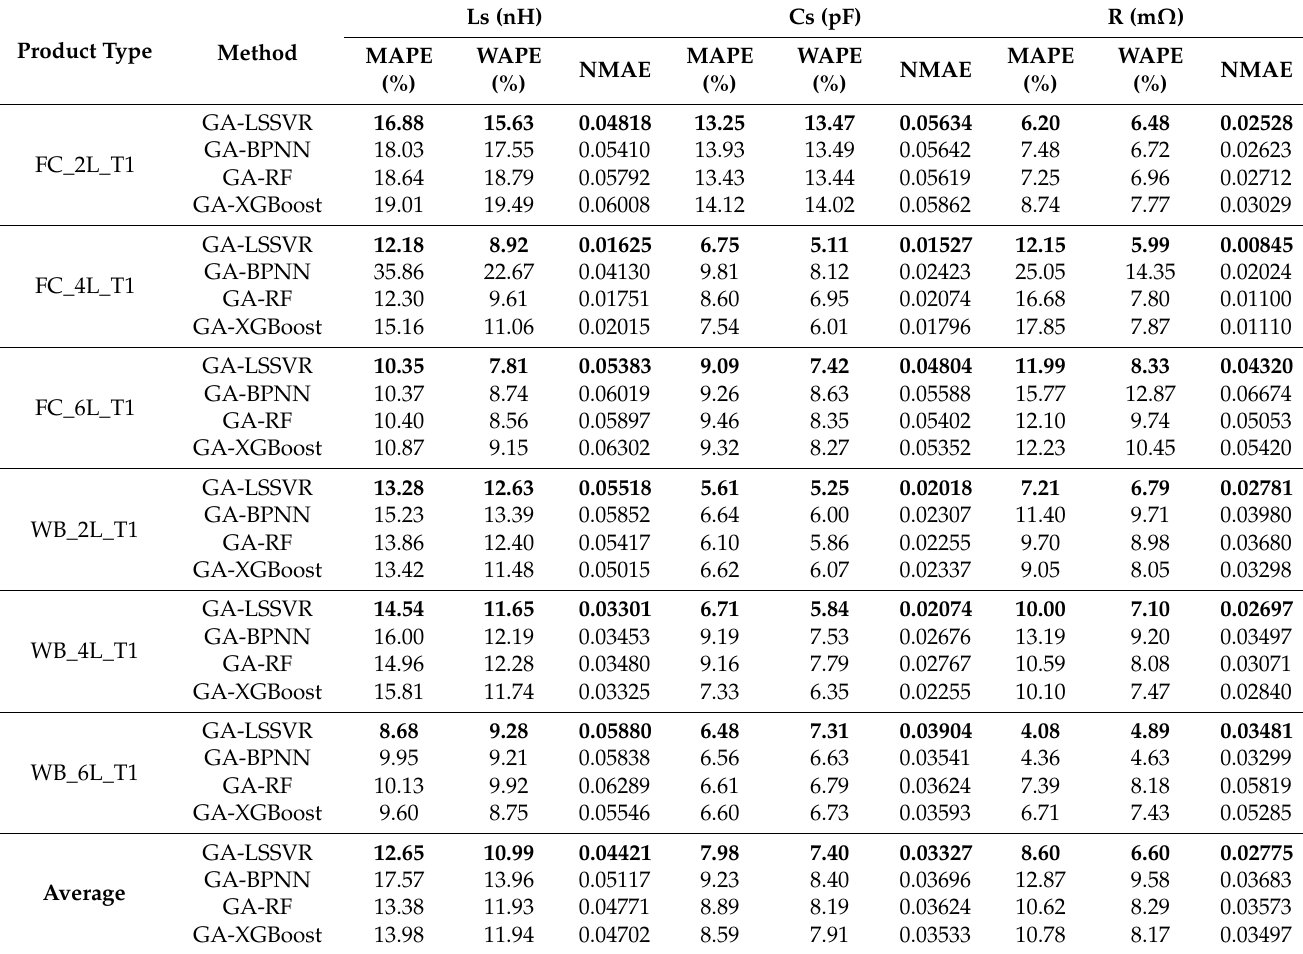
Table 5. Forecasting results of different models in terms of MAPE, WAPE, and